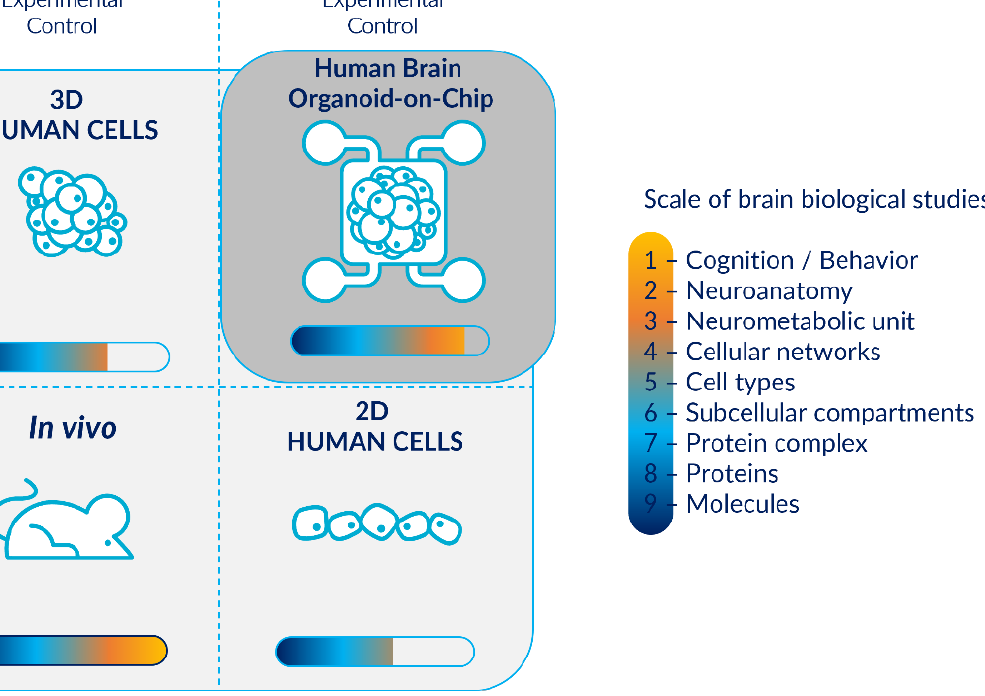
Figure 1. Human brain organoid-on-chips as physiologically relevant and reproducible models for the study of brain biological organization. Even if in vivo models enable a wider diversity of biological neurological studies, they are associated with low predictivity and experimental control. They are also considered as a black box model: often privileged by researchers despite the availability of other models. In contrast, in vitro 2D human cells allow high experimental control, however they have a low predictivity and do not permit brain biological studies at a higher scale than the cellular level. On the other hand, 3D structures such as cerebral organoids enable more complex studies with high predictivity but are associated with lower experimental control and high inter- and intra-batch heterogeneity. The combination of cerebral organoids with microfluidic technology provides a model with high experimental controllability, particularly for the modeling of physiological microenvironments in a minimalist approach, while ensuring a high predictivity, and enabling a wide range of biological